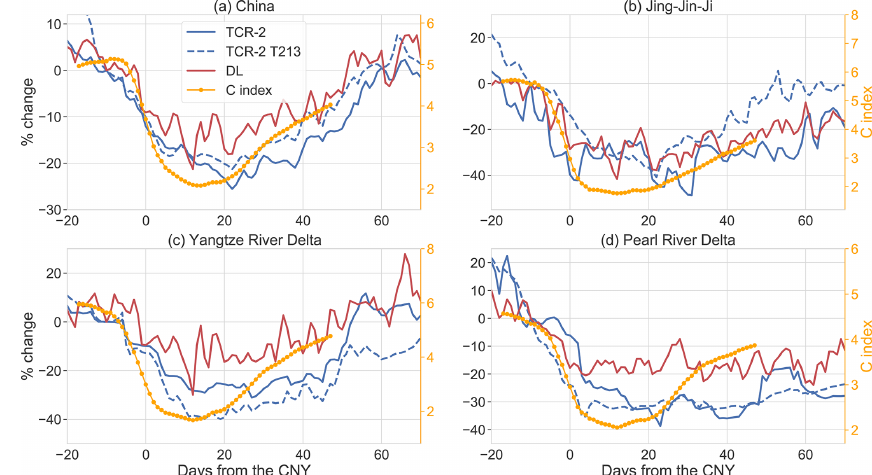
Figure 11. Time series of percentage changes in NO x emissions and the C-index Baidu mobility data, relative to 10d before the 2020 CNY, as a function of days from the CNY. Shown are the time series for (a) China, (b) the Jing-Jin-Ji region, (c) the Yangtze River Delta, and (d) the Pearl River Delta.